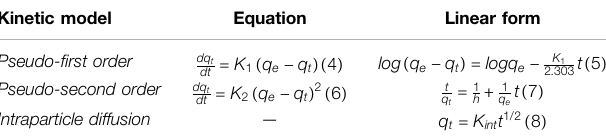
TABLE 2 | Kinetic model